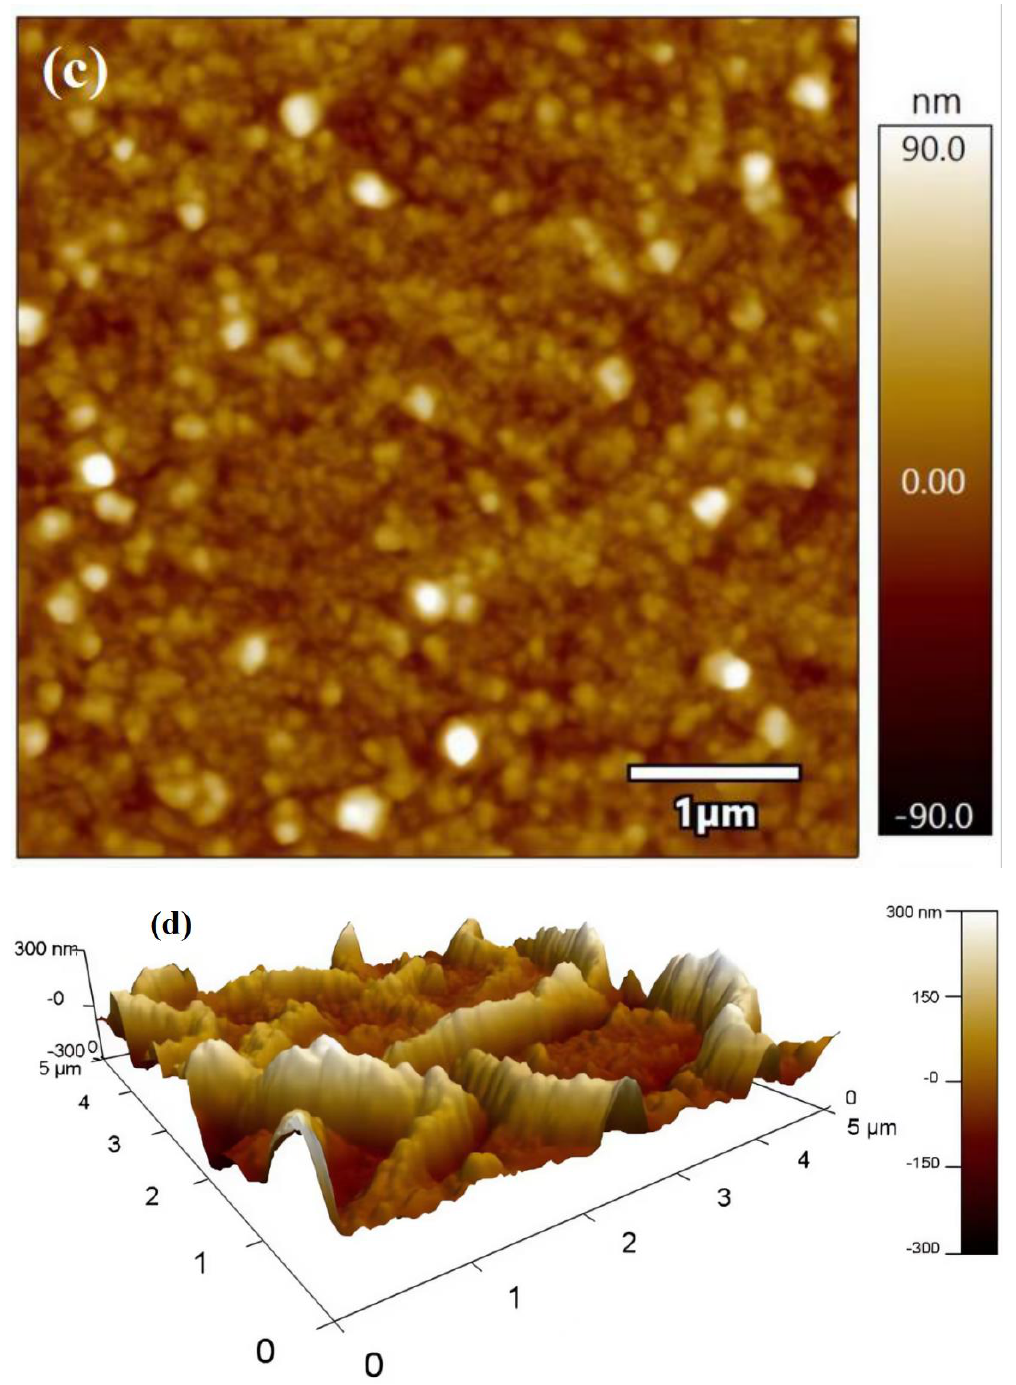
Figure 9. AFM of ZrO 2 /BCM ( a , b ) and IP − ZrO 2 /BC − NFM ( c , d ).